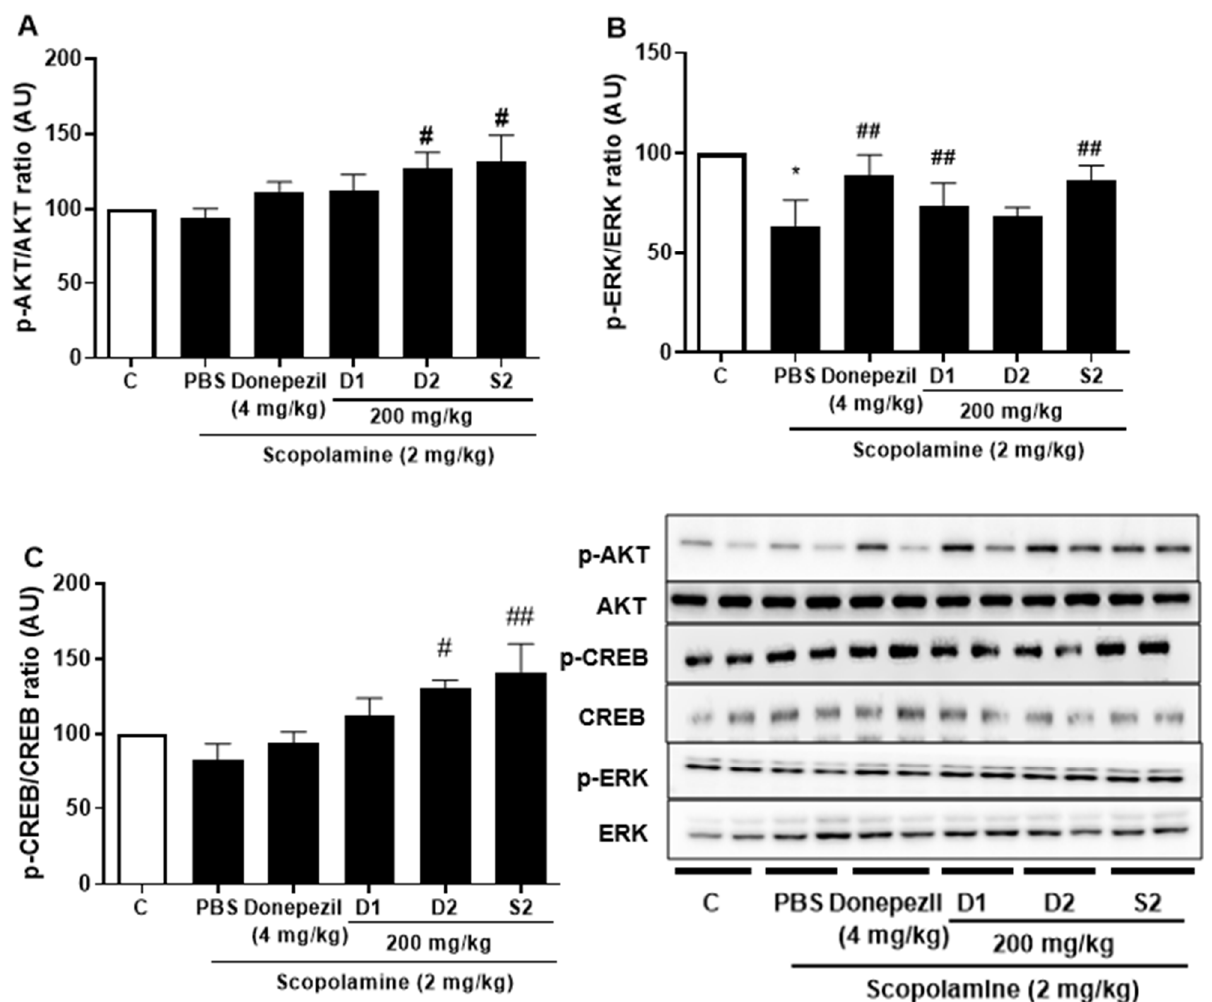
Figure 4. P. ginseng extracts suppressed memory related p-CREB/AKT/ERK signal pathway in scopolamine-induced mouse cortex. The expression of ( A ) p-AKT, ( B ) p-ERK, and ( C ) p-CREB were measured by western blot. Data are detected as mean ± SEM (n = 5). *: p < 0.05, the significant dif ‐ ference compared with the control . Compared with Scopolamine group, #: p < 0.05, ##: p < 0.01 (one ‐ way ANOVA followed by Dunnett’s multiple comparisons).